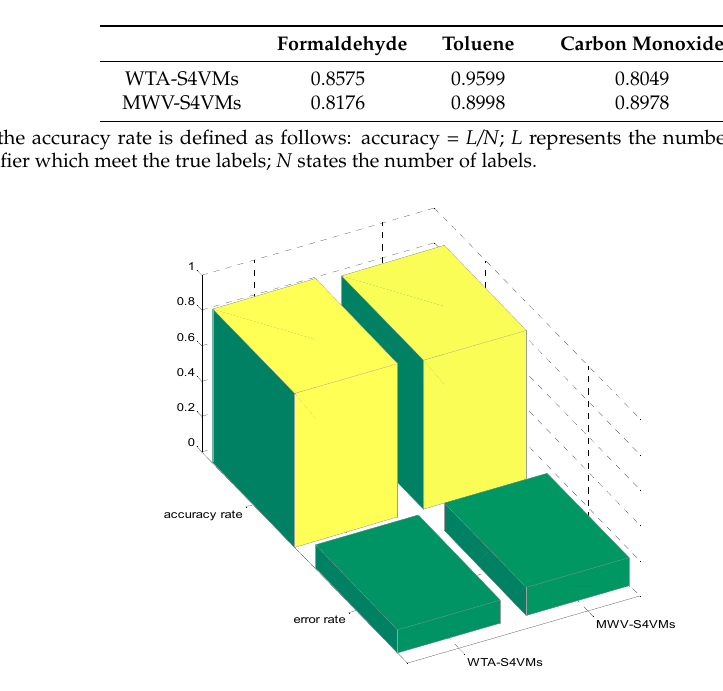
Figure 2. Accuracy of the two multi-classification methods. ( a ) WTA-S4VMs; ( b ) WTA-S4VMs. It is clear that WTA-S4VMs has better performance than MWV-S4VMs, so WTA-S4VMs was selected as the major multi-classifier method of M-S4VMs. Then we applied our optimizing methods to WTA-S4VMs. Table 7 illustrates the performance of these two methods and the different classification rates of these two methods. Then Table 8 show the classification rate with different unlabeled sample rates. Figures 3–6 show the classification rates of WTA-S4VMs and M-S4VMs with different unlabeled rates as well as the classification rates of the three gases with wrong labeled sample rates. Table 9 and Figure 7 show that the performance of M-S4VMs with different unlabeled rates from 10% to 90% where the total number of labeled samples and unlabeled samples are constant, but the number of unlabeled samples and labeled samples are dynamic as the unlabeled rate changes.